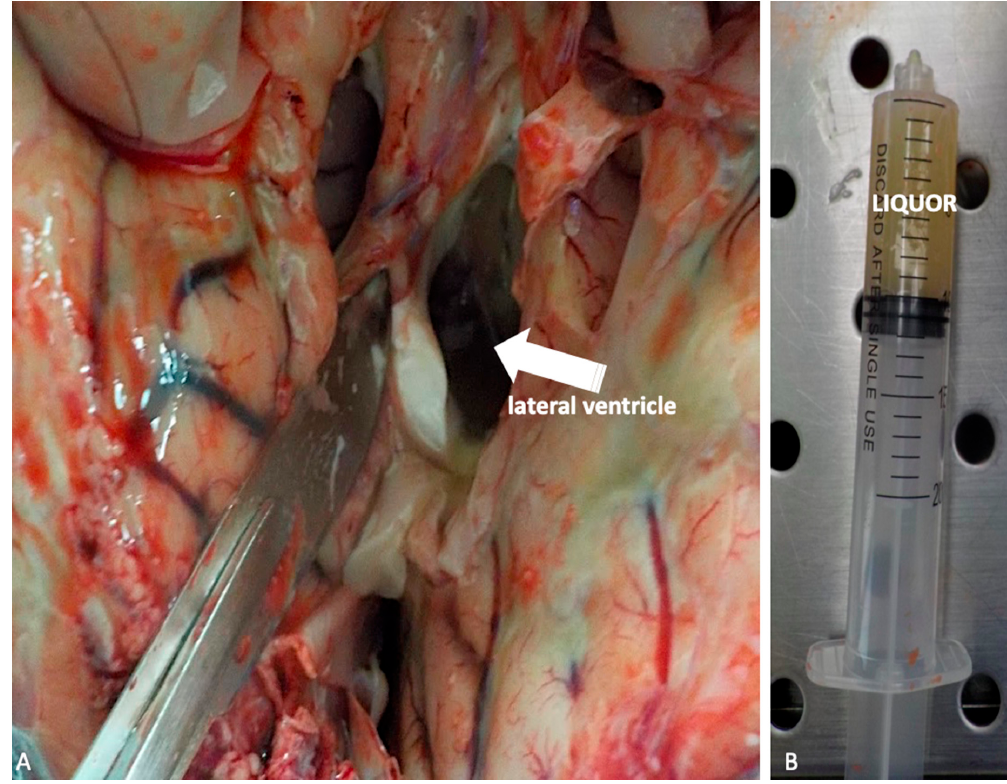
Figure 4. ( A – B ) Liquor sampling by lateral ventriculi in situ (white arrow) incision intended for microbiological analysis.